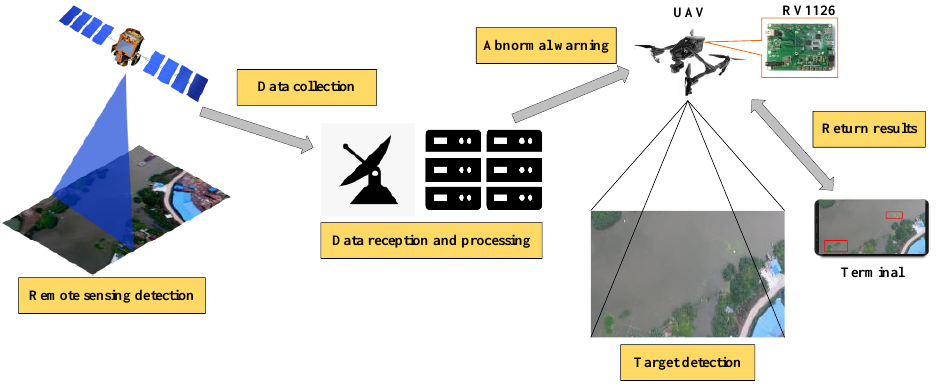
Figure 2. Remote sensing monitoring